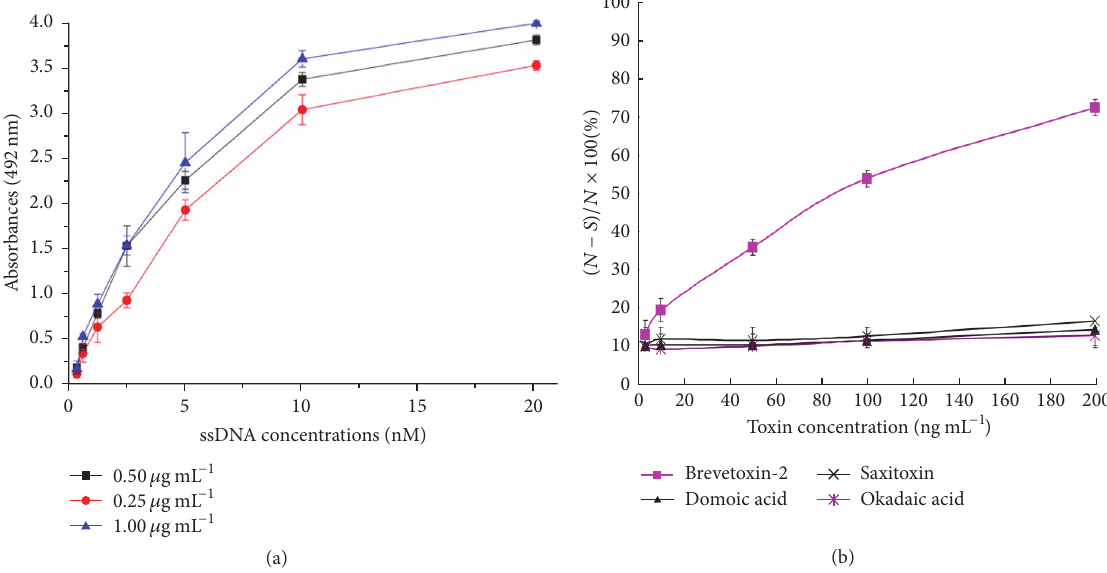
Figure 4: Binding activity and cross-reactivity of Bap5. (a) The 𝐾𝑑 value of the Bap5 aptamer was measured using different BTX-2-OVA coating concentrations (1, 0.5, and 0.25 𝜇 g mL −1 ) to estimate the dissociation constant ( 𝐾𝑑 = 1/𝐾𝑎 = (𝑛[ Ap 󸀠 ]𝑡 − [ Ap ]𝑡)/(𝑛 − 1) ). The 𝑥 - axis represents the aptamer concentration (ngmL −1 ), whereas the 𝑦 -axis represents the absorbance at 492 nm. (b) Plots from the ELISA experiments used to investigate the specificity of the Bap5 aptamer for BTX-2 and other toxins. The calibration curve was obtained with the inhibition percent [(𝑁 − 𝑆)/𝑁 × 100 % ] shown on the 𝑦 -axis and the concentration of toxins on the 𝑥 -axis. 𝑁 is the OD 492 value when the toxin standard is not present in the detected sample (control), and 𝑆 is the OD 492 value when there is a difference in the concentration of the standard in the detected sample. All the data represent the means ± SD ( 𝑛 = 3 ) of three